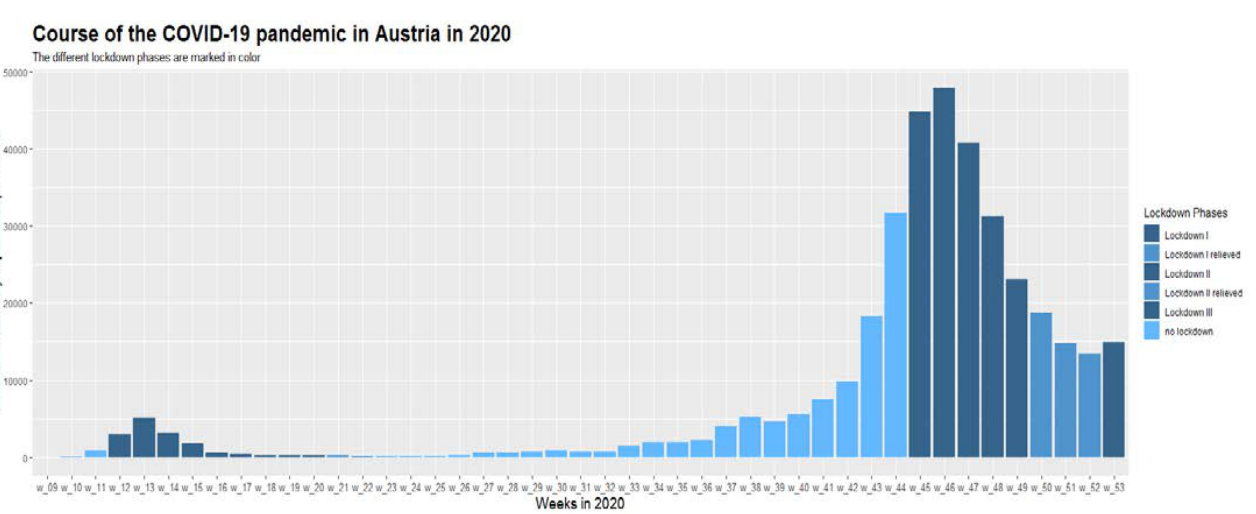
Figure 2. Positive COVID-19 cases by week in 2020 in Austria (first positive laboratory diagnosis).